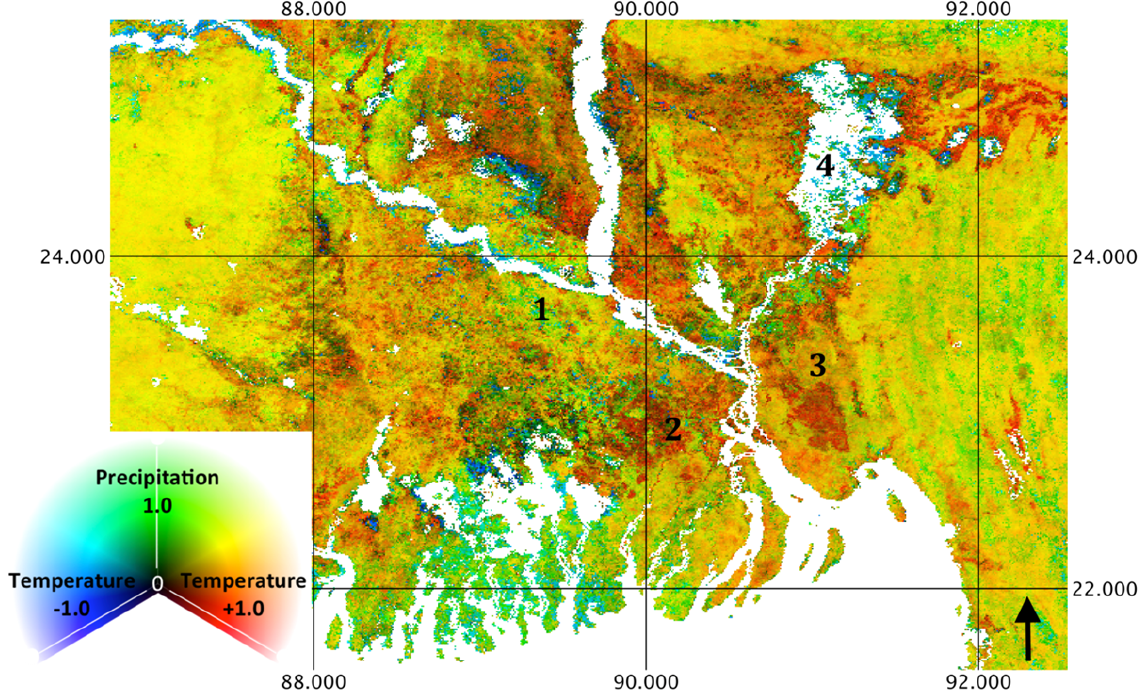
Figure 11. Combined correlations for precipitation (positive) and temperature (positive and negative) illustrating different cropping systems in the Ganges River Delta, Bangladesh. 1-km